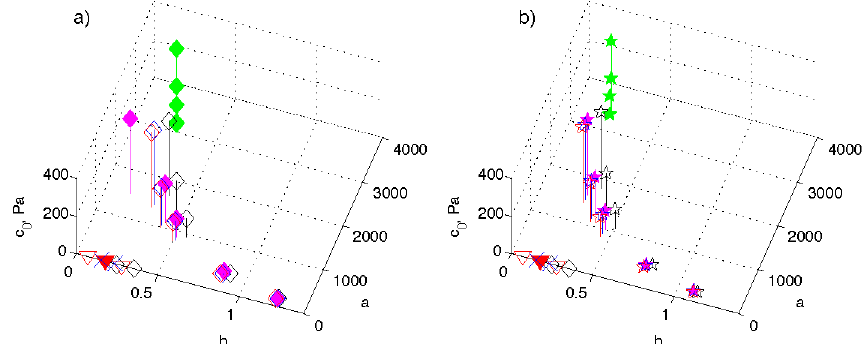
Figure A1. Sensitivity analysis of power law fit parameters a and b to uncertainty in c 0 for each set of loading conditions (see the main text for details; marker code is the same as in Fig. 3); (a) the filtered population of tests, where the first measurement is at 1min, or (b) at 30s. For comparison b axes provide exponents from other studies (marker code is the same as in Fig.